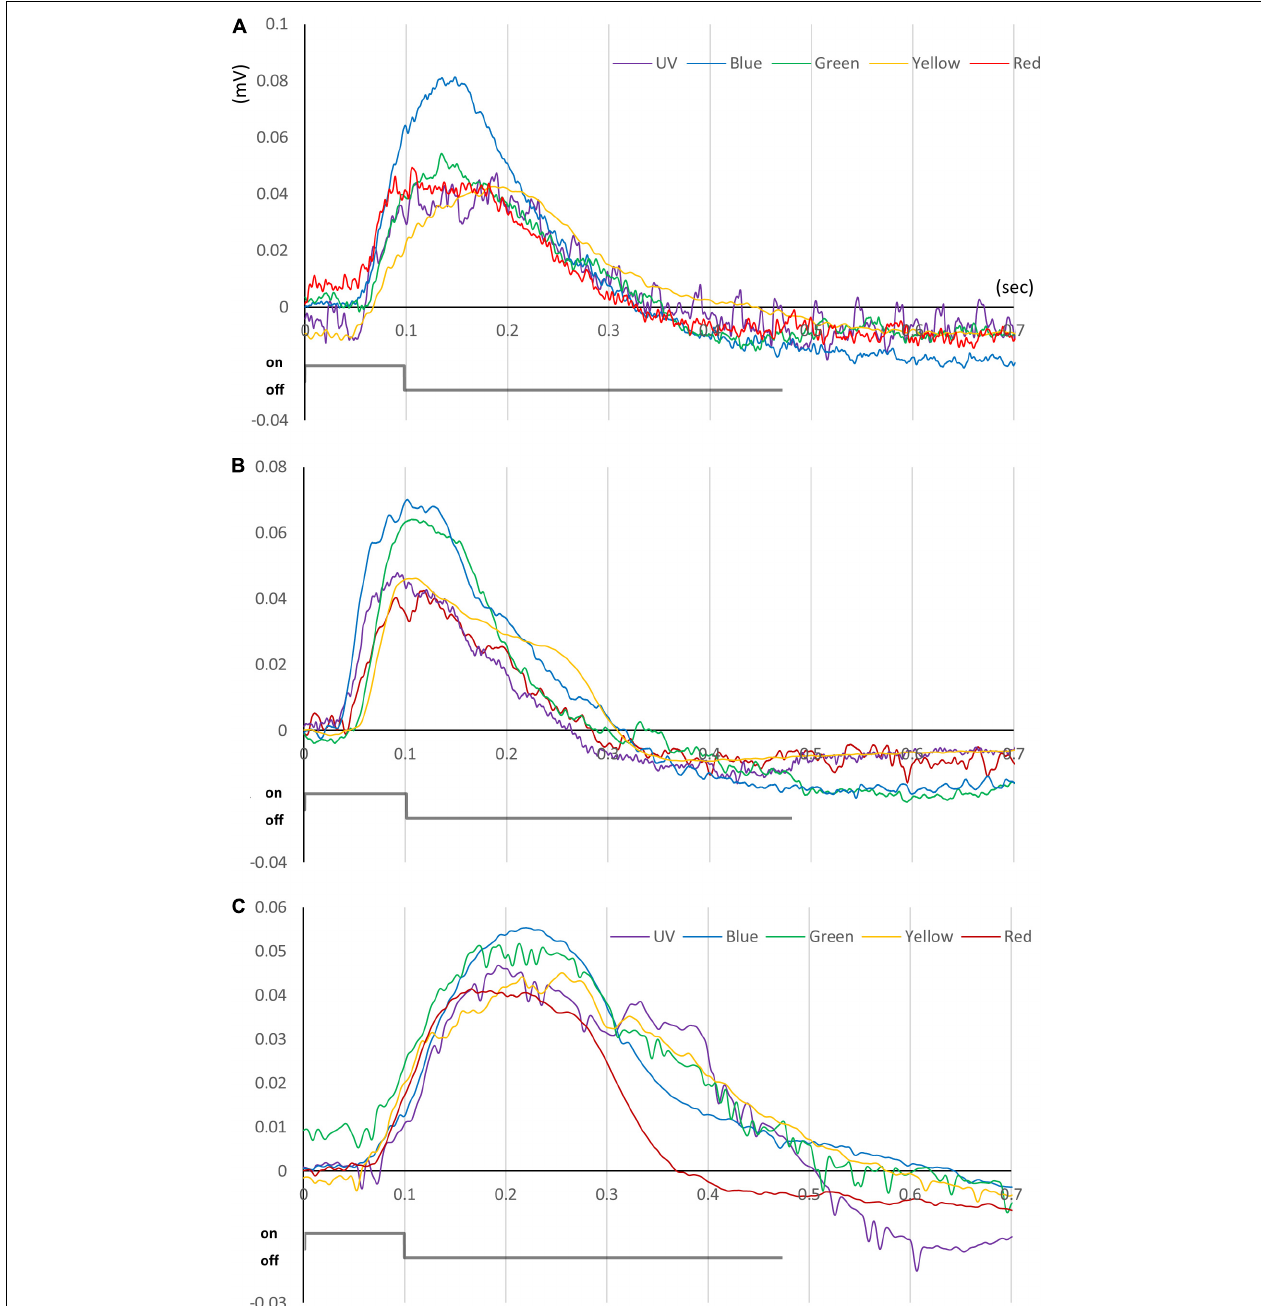
FIGURE 5 | ERG traces for slipper lobsters. Data for (A) S. squammosus , (B) I. novemdentatus , and (C) P. japonicas are shown. Typical ERG traces taken from appropriate light stimuli for each spectrum. The color of each line represents the color of each stimulus. The intensities of the color stimuli were c. 10 - 2 –10 0 mol/m 2 /s for I. novemdentatus and c. 10 - 1 –10 1 mol/m 2 /s for S. squammosus and P. japonicas .